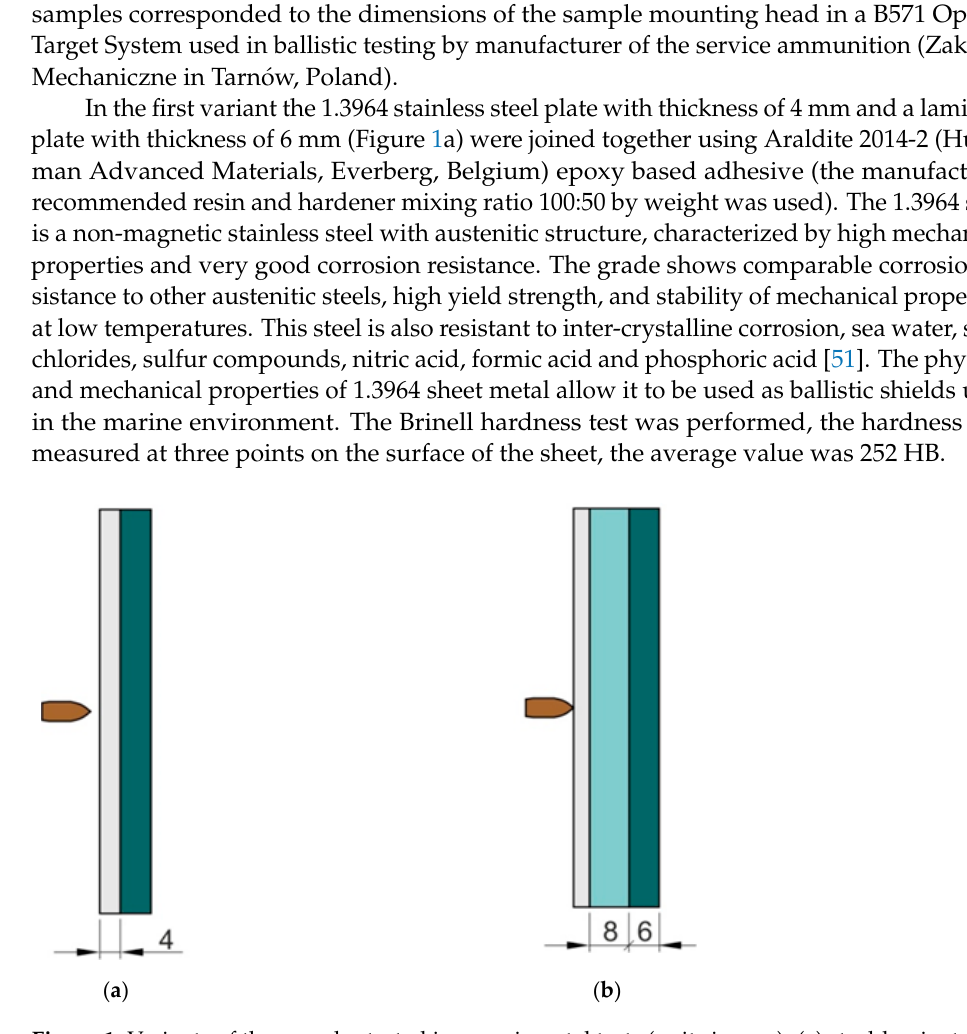
Figure 1. Variants of the samples tested in experimental tests (units in mm): ( a ) steel ‐ laminate and ( b ) steel ‐ glycol ‐ laminate.